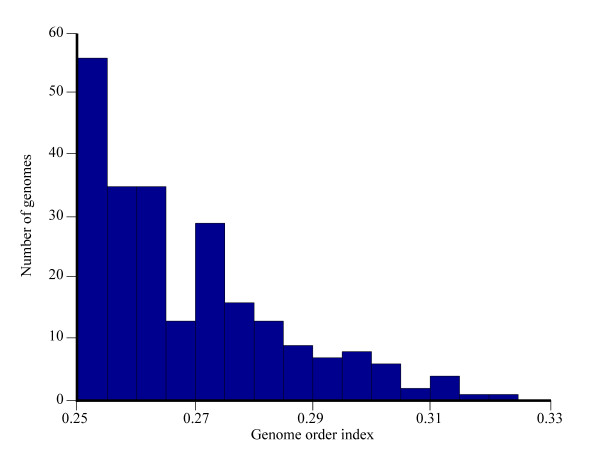
Histogram of the genome order index S for 235 bacterial genomes.